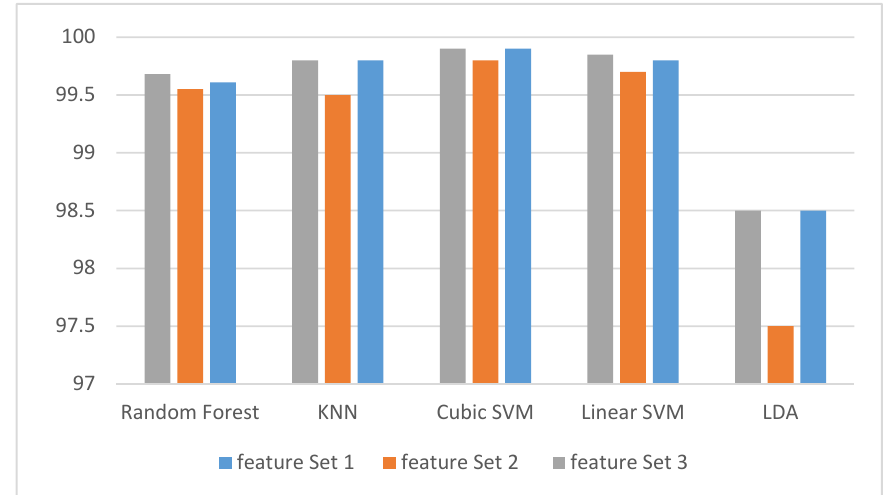
Figure 4. The classification accuracies for detecting stress and non-stress states for our three subsets of features. Diagnostics. 2020 , 10 , x FOR PEER REVIEW Table 3. Evaluation metrics (with their 95% confidence intervals) for detecting stress using Feature-Set 3 .